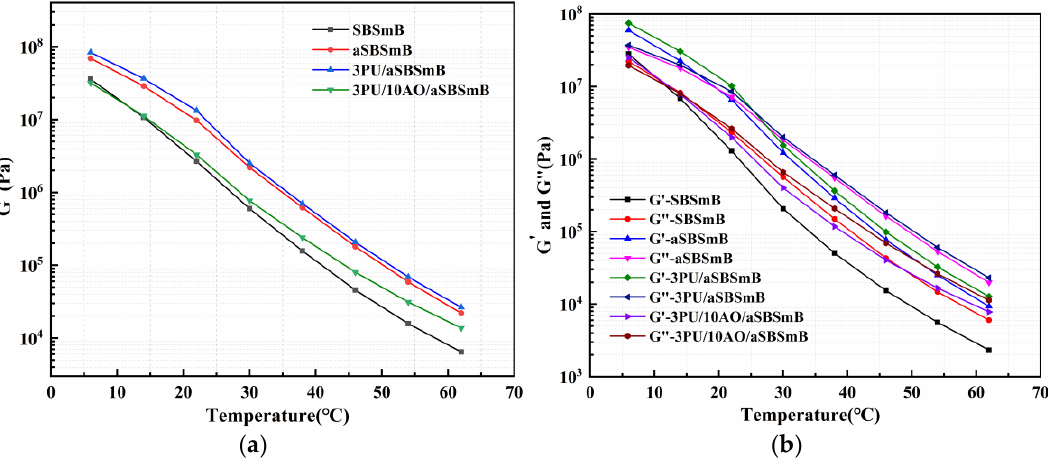
Figure 9. Temperature response to viscoelastic behavior of reaction-rejuvenated SBSmB: ( a ) Complex Modulus; ( b ) Elastic/Viscous Modulus.